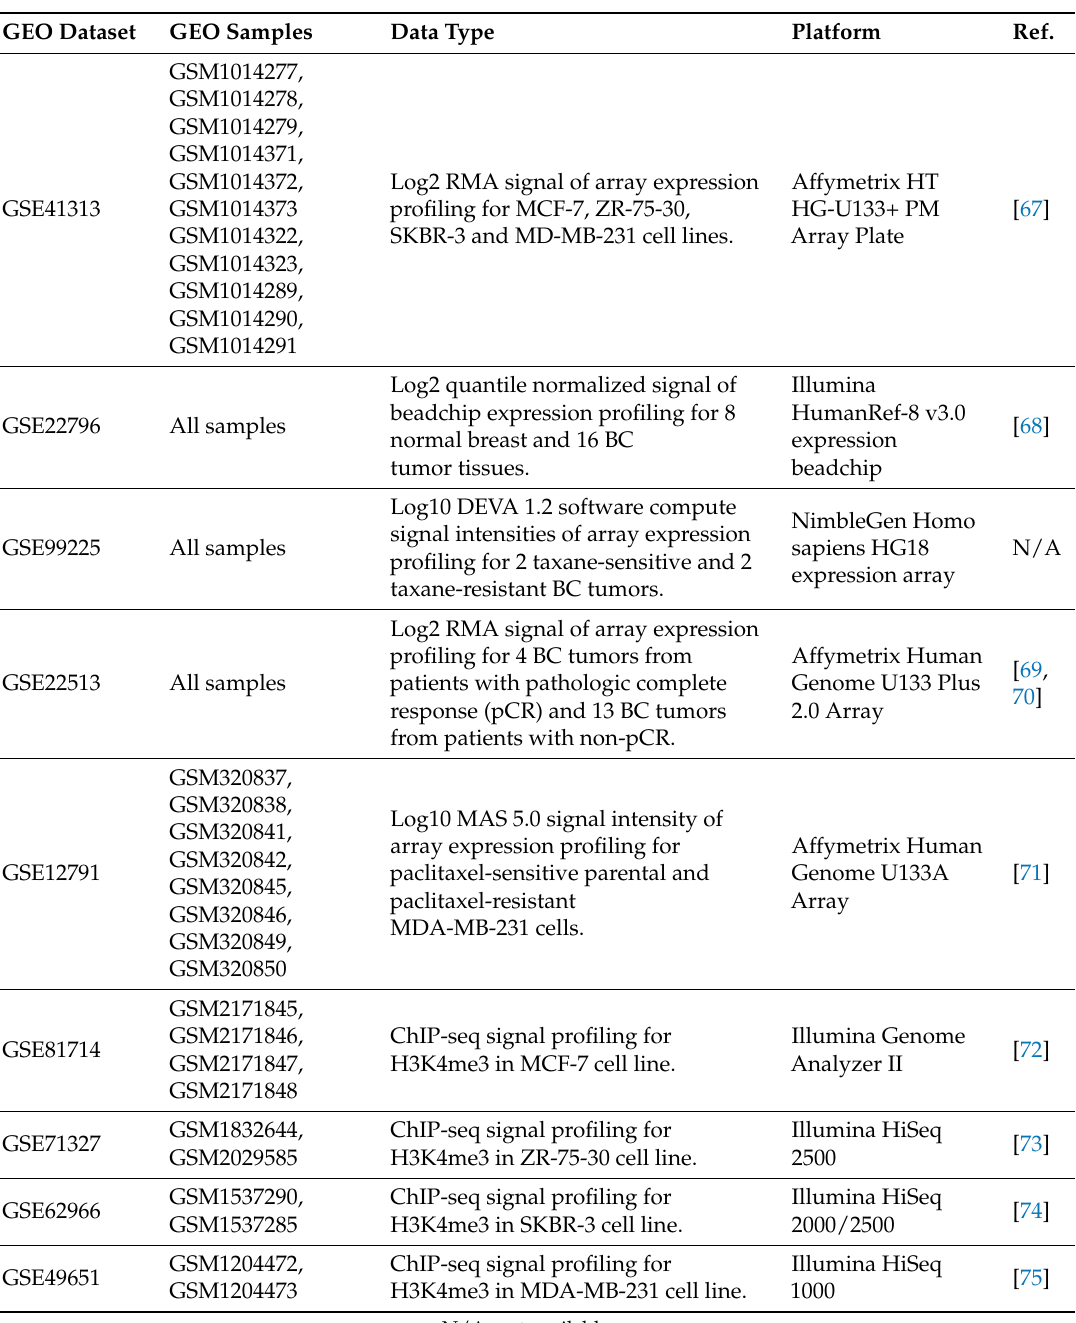
Table 1. GEO dataset and sample identifiers analyzed in this study. GEO